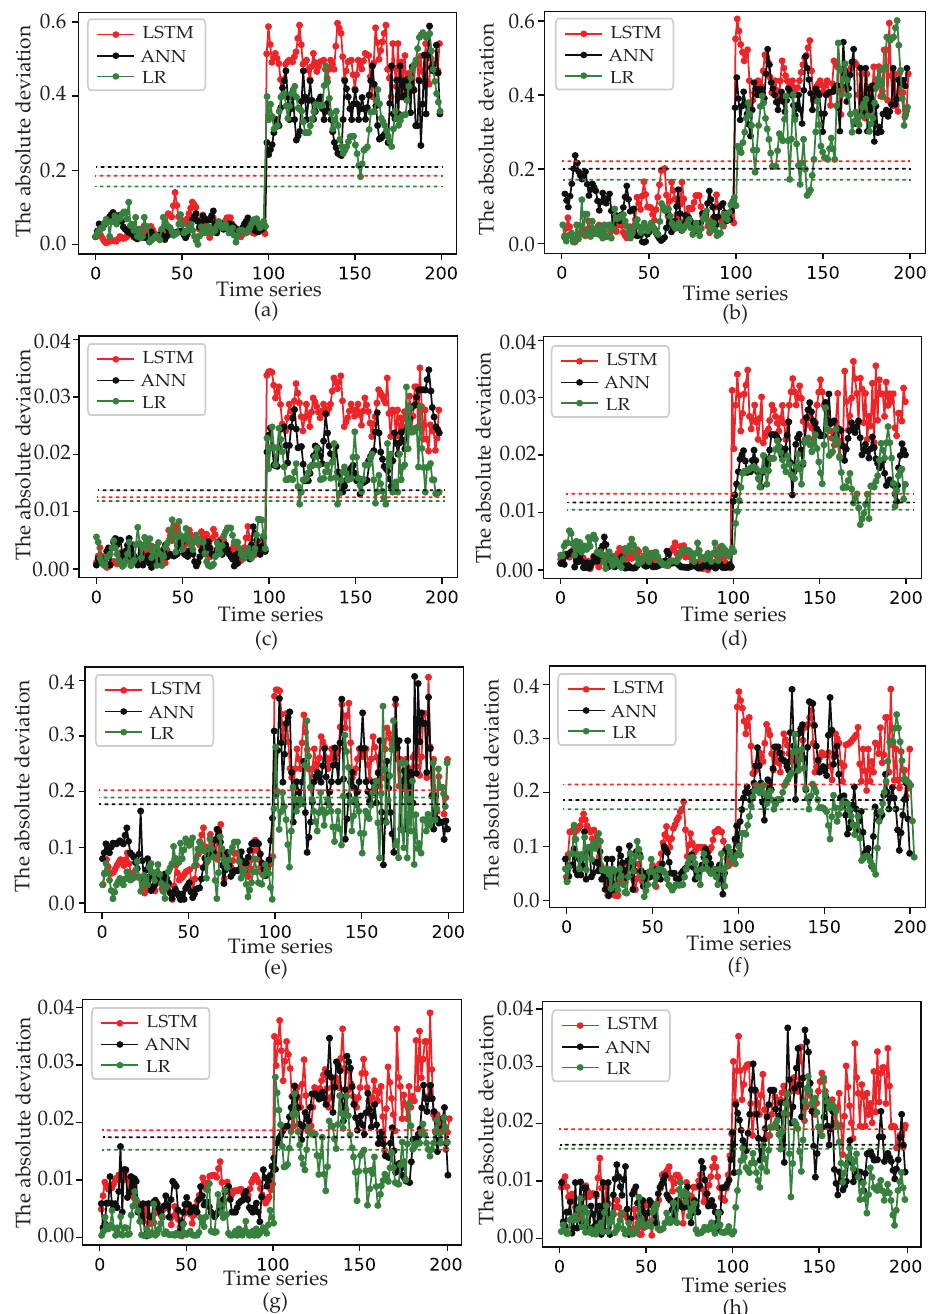
Figure 7. The absolute deviation of T suc and P suc . ( a ) The absolute deviation of virtual sensor T (cid:48) suc when the grouping threshold takes 0.8; ( b ) The absolute deviation of virtual sensor T (cid:48)(cid:48) suc when the grouping threshold takes 0.8; ( c ) The absolute deviation of virtual sensor P (cid:48) suc when the grouping threshold takes 0.8; ( d ) The absolute deviation of virtual sensor P (cid:48)(cid:48) suc when the grouping threshold takes 0.8; ( e ) The absolute deviation of virtual sensor T (cid:48) suc when the grouping threshold takes 0; ( f ) The absolute deviation of virtual sensor T (cid:48)(cid:48) suc when the grouping threshold takes 0; ( g ) The absolute deviation of virtual sensor P (cid:48) suc when the grouping threshold takes 0; ( h ) The absolute deviation of virtual sensor P (cid:48)(cid:48) suc when the grouping threshold takes